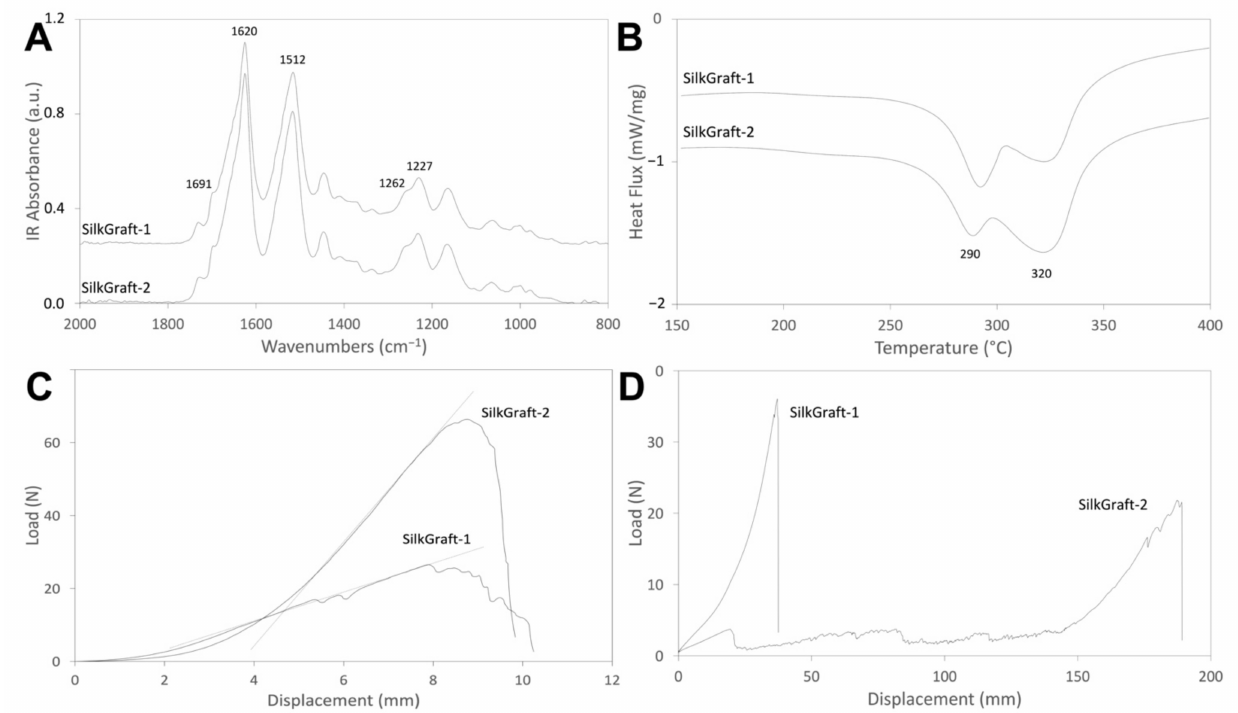
Figure 3. ( A ) ATR-FTIR spectra of SILKGraft designs 1 and 2. ( B ) DSC thermograms of SILKGraft designs 1 and 2. ( C ) Circumferential tensile curves of SILKGraft designs 1 and 2. ( D ) Longitudinal tensile curves of SILKGraft designs 1 and 2. Table 3. Thermal properties and degree of crystallinity. SILKGraft